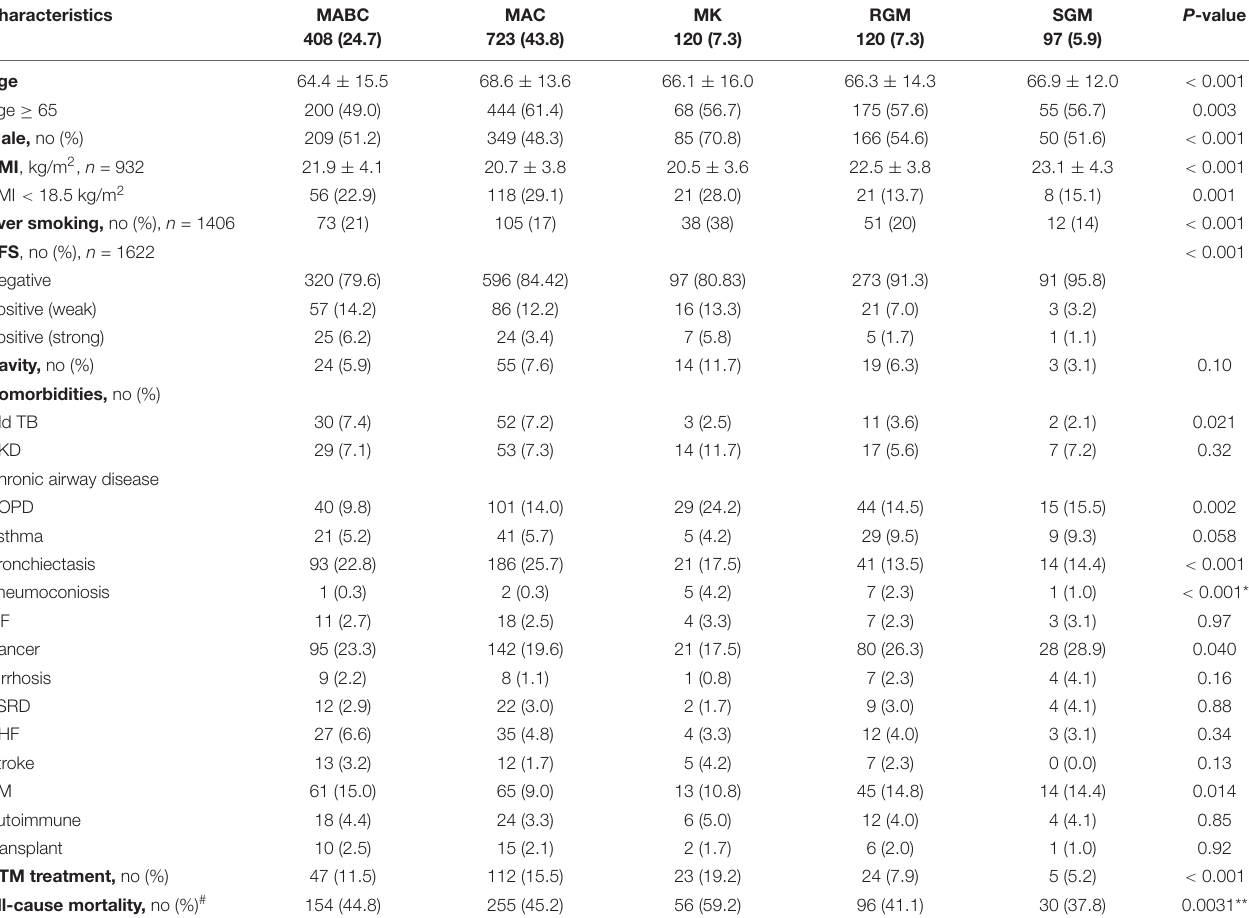
TABLE 3 | Characteristics of patients with NTM-LD stratified by NTM species.